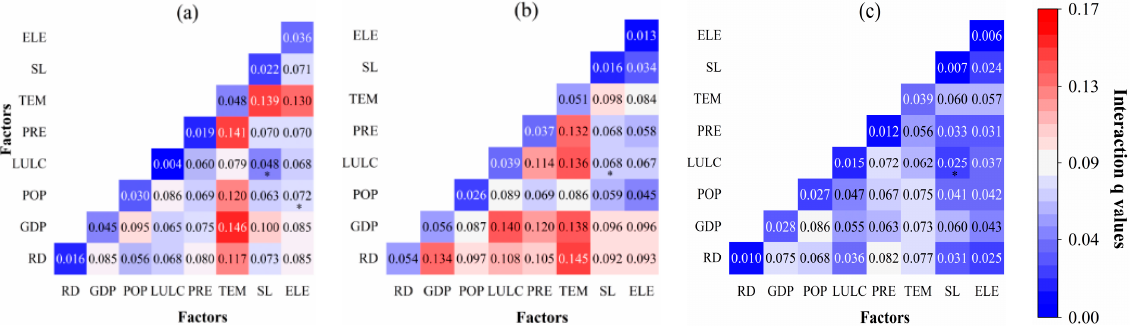
Figure 11. The q values of interactions between factors in Wuxi area from 2000 to 2020: 2000 ( a ), 2010 ( b ), 2020 ( c ). Note: * represents the interaction types of bi-linear enhancement.